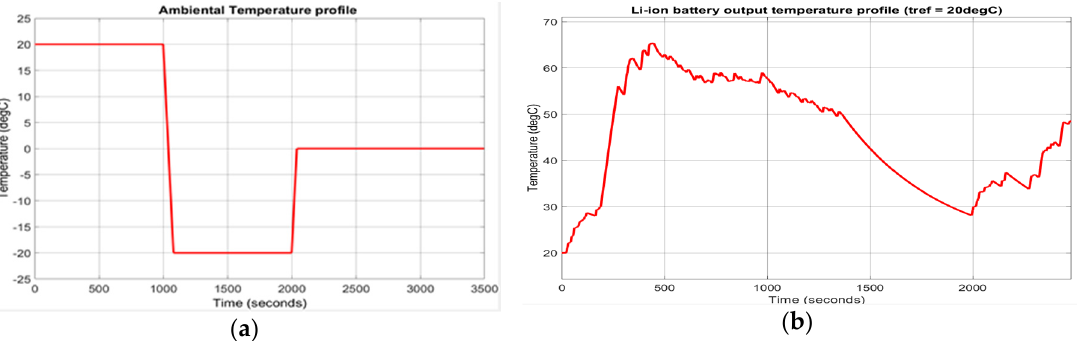
Figure 10. ( a ) The input ambient temperature profile; ( b ) the output temperature as response to input ambient temperature of the thermal model block.